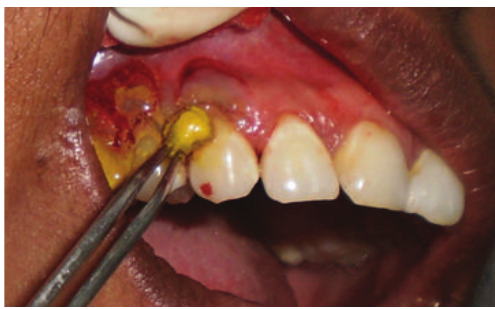
Figure 3: Root conditioning with tetracycline.